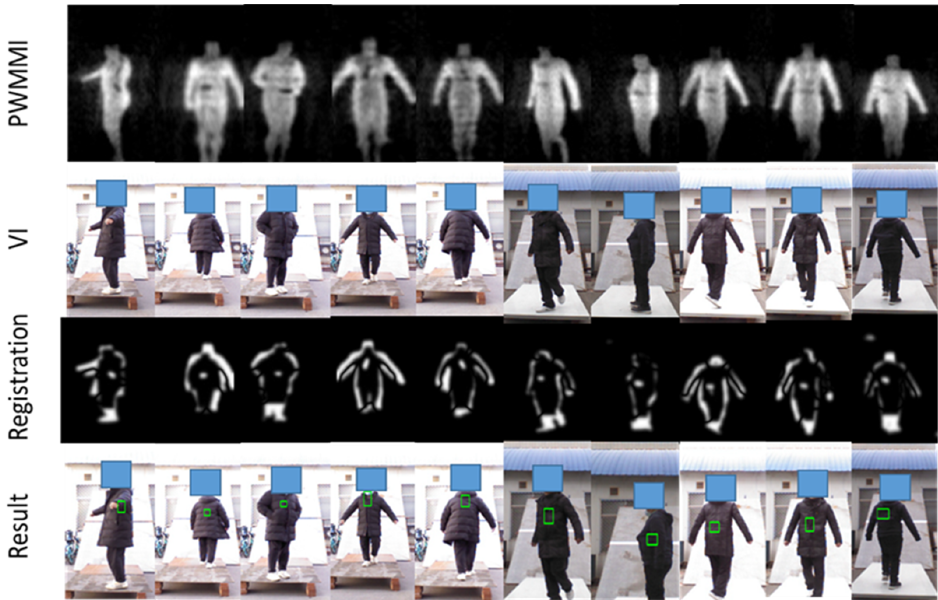
Figure 16. Location results of metallic threats based on multi-frame synthesis. The detected metallic threats are marked with a green box on VI.